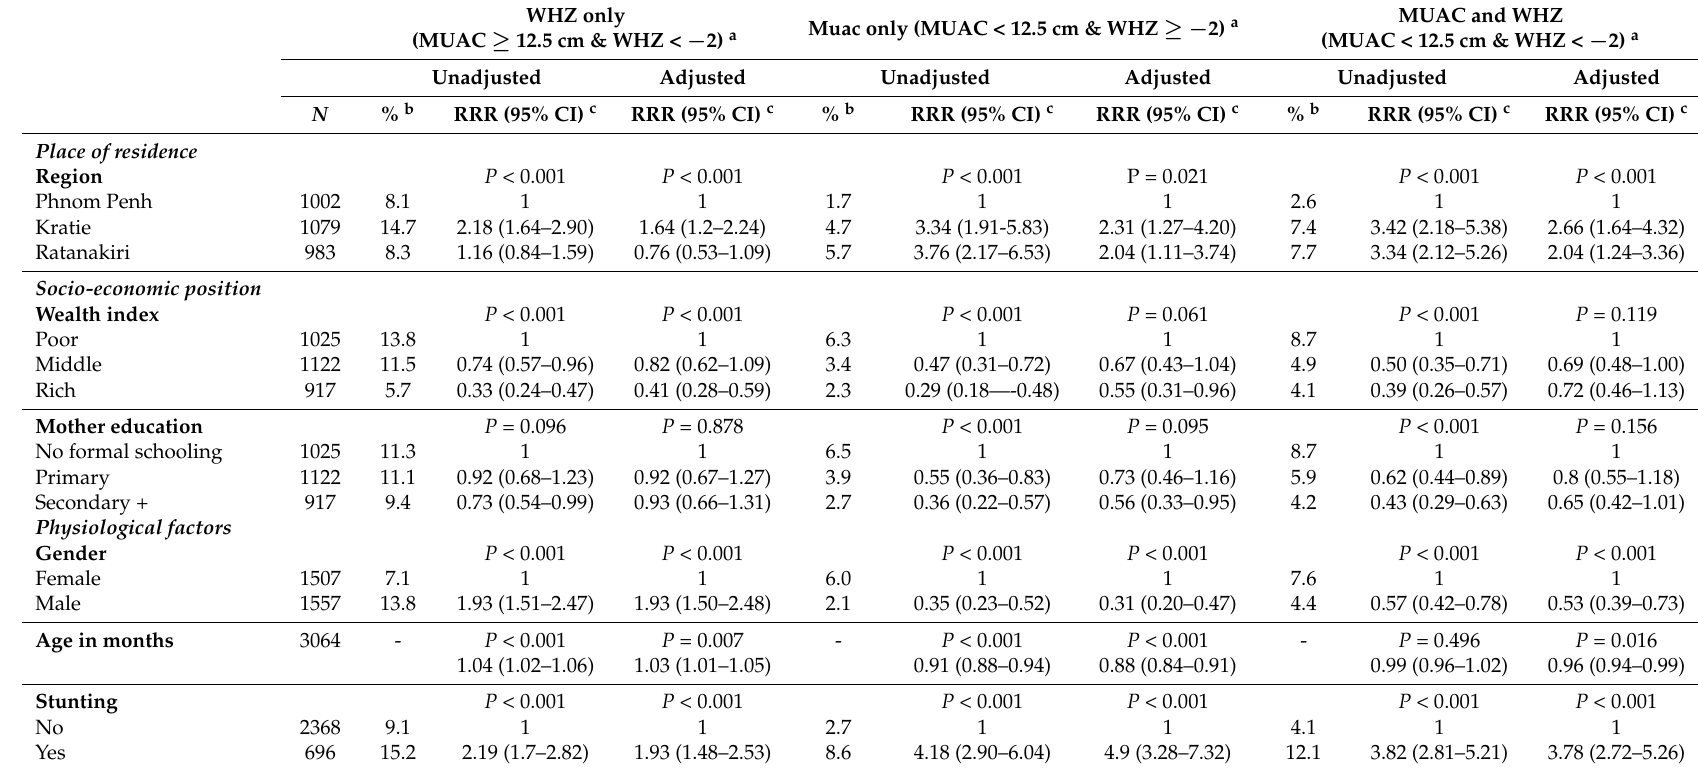
Table 2. Multinomial regression: wasting by MUAC only, WHZ only and both MUAC and WHZ compared to the non-wasted children; by place of residence, socio-economic and physiological